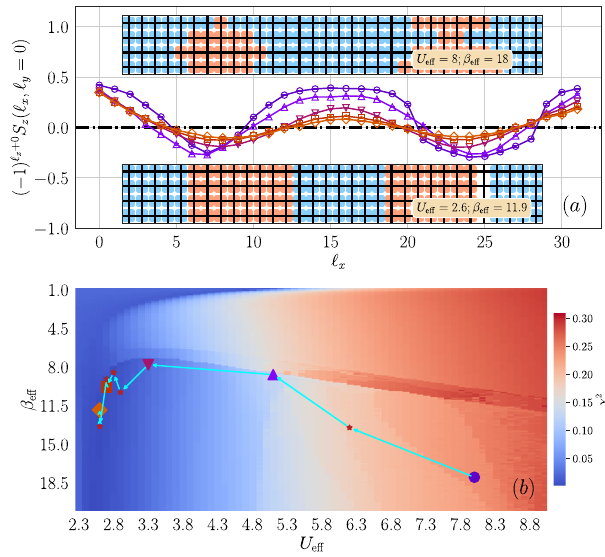
FIG. 1. Systematic improvement of the AFQMC accuracy using the self-consistent constraint. (a) The main plot shows the staggered spin density ð − 1 Þ l x þ 0 S z ð l x ; l y ¼ 0 Þ versus site l x , obtained from AFQMC at five representative steps in the self- consistent iteration. Statistical error bars are much smaller than symbol size. The insets show visualization of the real-space spin density obtained from AFQMC in the first and last iterations (corresponding to the circle and diamond in the second panel, respectively). Blue and orange mark regions of AFM spin densities with a phase change between them. (White means the magnitude of the spin density is smaller than twice the AFQMC statistical error bars.) (b) The trajectory of how ð U eff ; β eff Þ evolve in the self-consistent procedure is shown on ; β . Each solid symbol denotes the the heat map of χ 2 ð U eff eff Þ effective interaction and temperature parameters of the IP Hamiltonian at one step of the iteration, and the light blue arrows indicate the direction in the iteration. The five selected steps shown in (a) are indicated here by their corresponding symbol shapes, while all other steps are shown as stars. The system is 32 × 4 with δ ¼ 1 = 8 and U ¼ 8 , at inverse temperature β ¼ 18